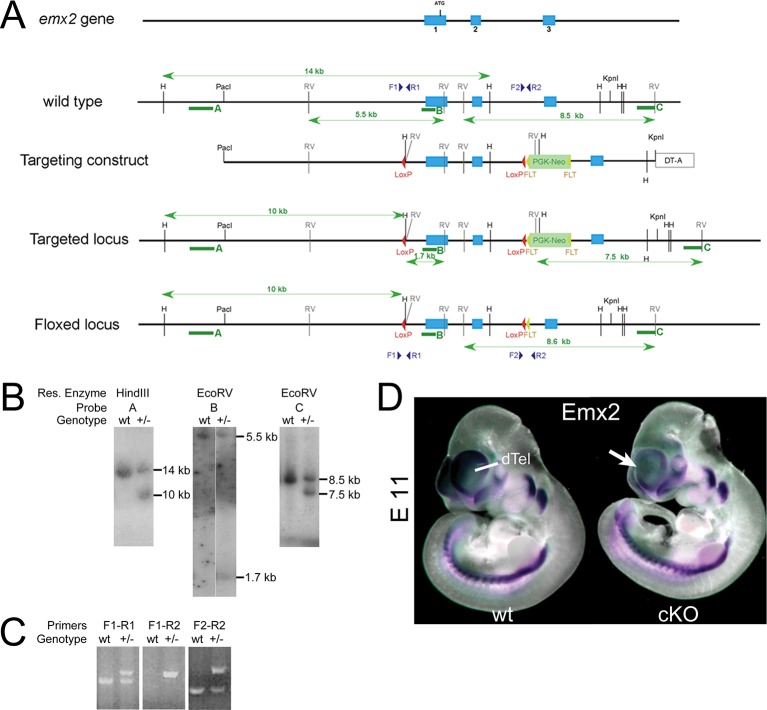
Generation of Emx2-floxed mice and confirmation of cortex specific Emx2 deletion.(A) Targeting strategy of the Emx2 locus: Blue shapes indicate exons of the Emx2 gene. Red and yellow triangles indicate LoxP and FRT sites. RV, EcoRV; H, HindIII indicate restriction enzyme cutting sites. The targeting construct included LoxP sites flanking Emx2 exons 1 and 2 followed by a FRT-site-flanked PGK-Neo cassette. (B) Southern blot hybridization of wt and Emx2 floxed heterozygous (+/–) embryonic stem cell clones with probes A, B, and C (denoted by green arrows in A). Blots of HindIII digested genomic DNA that were hybridized with probe A revealed a 14kb Emx2 wt band and a 10 kb Emx2 floxed band. EcoRV digestion and hybridization with probe B revealed a 5.5kb Emx2 wt band and a 1.7 kb Emx2 floxed band. EcoRV digestion and hybridization with probe C revealed a 8.5kb Emx2 wt band and a 7.5kb Emx2 floxed band. (C) Genomic DNA from wt and Emx2 heterozygous (+/–) embryonic stem cell clones was amplified by PCR using combinations of the primers (F1, R1, F2, R2, genomic location indicated in A) revealing a Emx2 wt PCR product (~300 bp) and a Emx2 floxed PCR product (~400 bp). (D) WMISH at E11 using a Emx2 probe showed that Emx2 expression was intact in the entire embryo in homozygous Emx2 floxed embryos (Emx2fl/fl: considered as wt control). Conversely, WMISH using Emx1-IRES-Cre-mediated conditional Emx2 knock out animals (Emx2fl/fl- Emx1-IRES-Cre+: cKO) reveals specific deletion of Emx2 activity from cortical progenitors in the dTel, while leaving Emx2 expression in the rest of the embryo intact. dTel, dorsal telencephalon; PCR, polymerase chain reaction; WMISH, whole mount in situ hybridization; wt, wildtype.